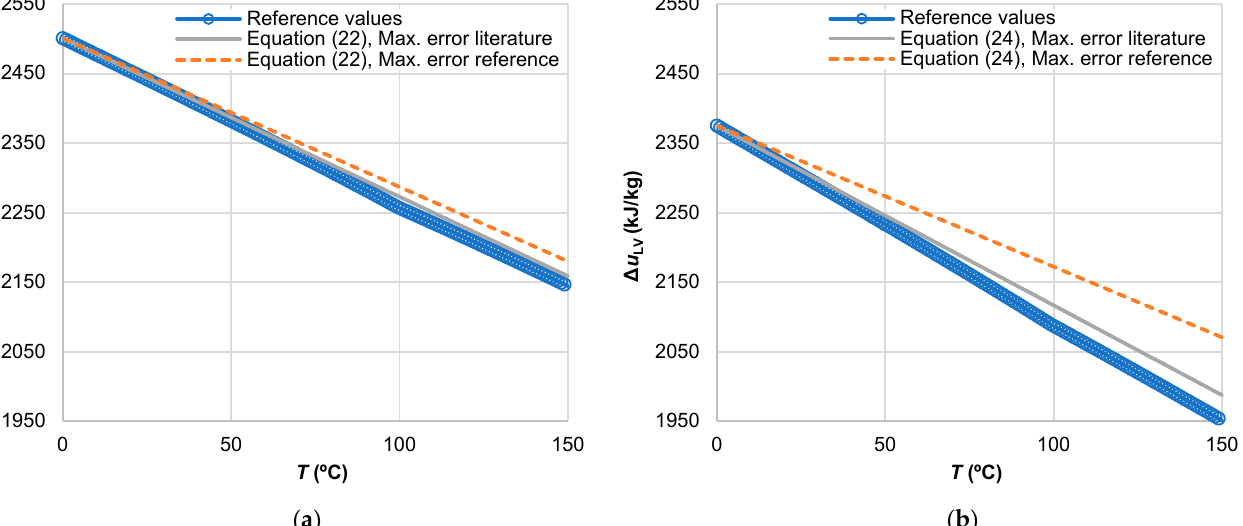
Figure 8. Relative error in Δ h LV and Δ u LV at 150 °C using specific heat capacity pairs from reference values [13] at temperatures 0–150 °C.